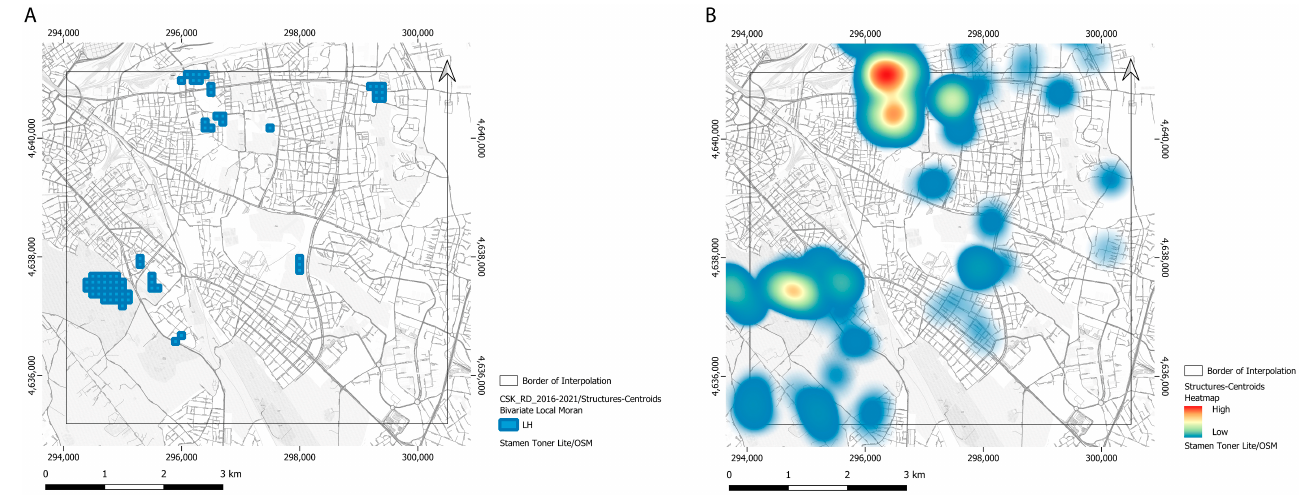
Figure 17. ( A ) Bivariate Local Moran analysis output shows the areas of inverse correlation between the cold spots of the CSK_RA velocity map and the hotspots of the quarry-related structures, shown in the Low/High (LH) class as blue cells and ( B ) heatmap of the centroids of historical quarry-related structures.